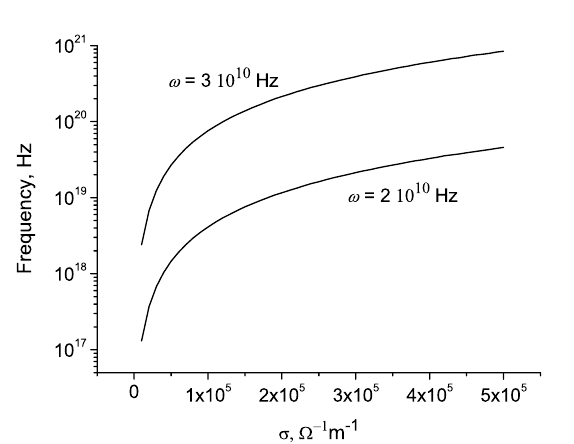
Figure 9. Photon frequency as function of conductivity. r 0 = 0.01 m.